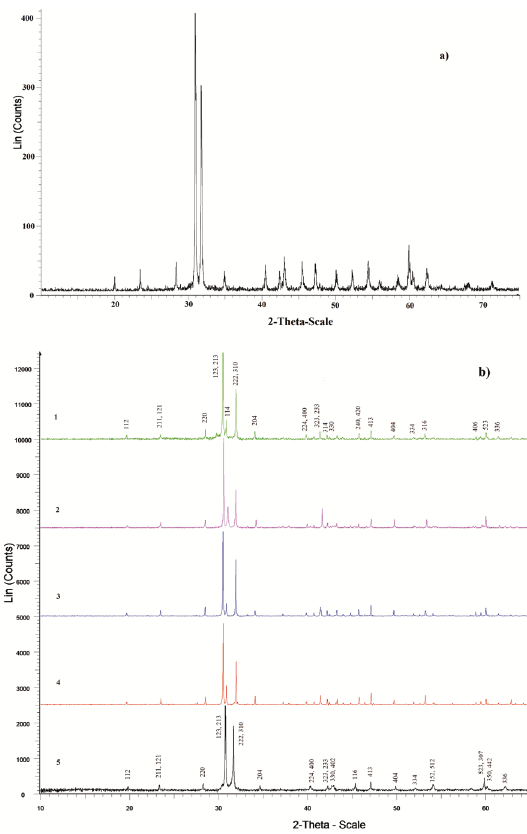
Te (a), as well as Tl PbTe , 5 3 4 3 PbTe -Tl TbTe section (b). 4 3 9 6